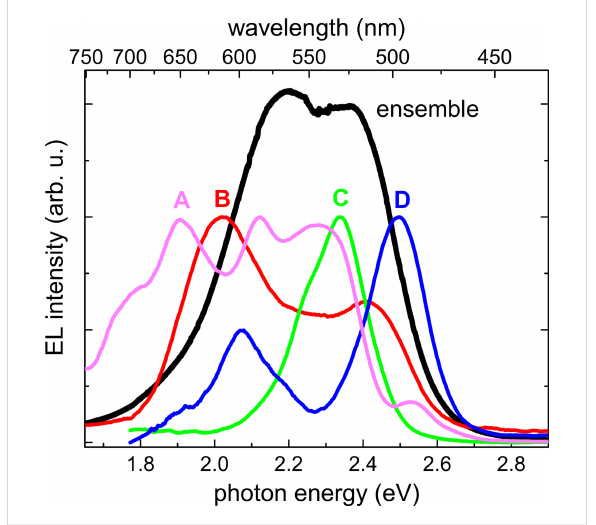
Figure 2: The colored spectra (normalized) represent the EL measured with the probe tip at four different positions on the unprocessed NW ensemble for a driving current of 100 nA. The black spectrum is the EL of the processed ensemble LED